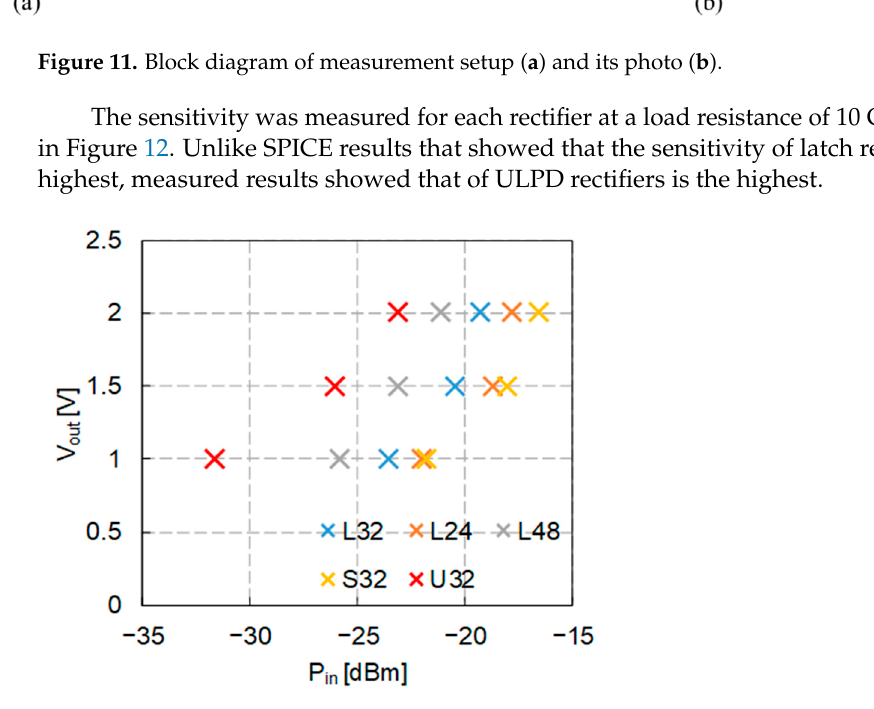
Figure 13. Schematic for SPICE simulation including parasitic elements in microstrip lines and bonding wires.